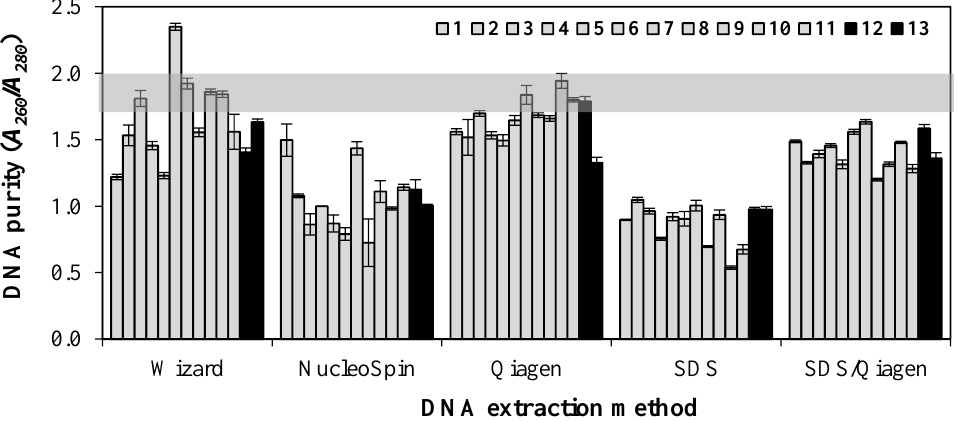
Figure 2. Comparison of purity of DNA extracted from 13 EBN samples with five different DNA extraction methods. Samples 1 – 11 are unprocessed EBNs and samples 12 – 13 are processed EBNs. Grey shaded area represents satisfactory range for pure DNA from 1.7 to 2.0. Values are mean ± standard error with samples size.